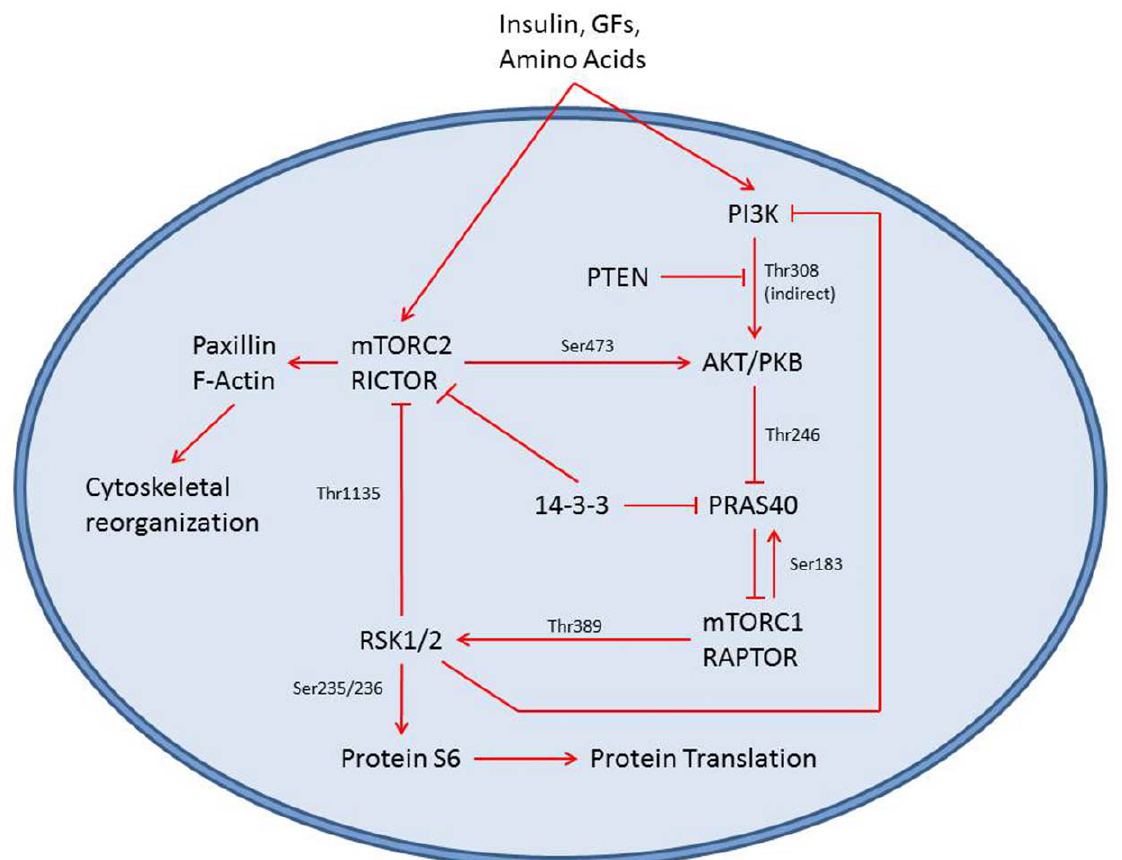
Figure 1. Simplified PI3K/AKT pathway map. In this study we examine the levels of PI3K, mTOR and phosphorylated Protein S6 as indicators of cellular response to PI3K/mTOR inhibition.